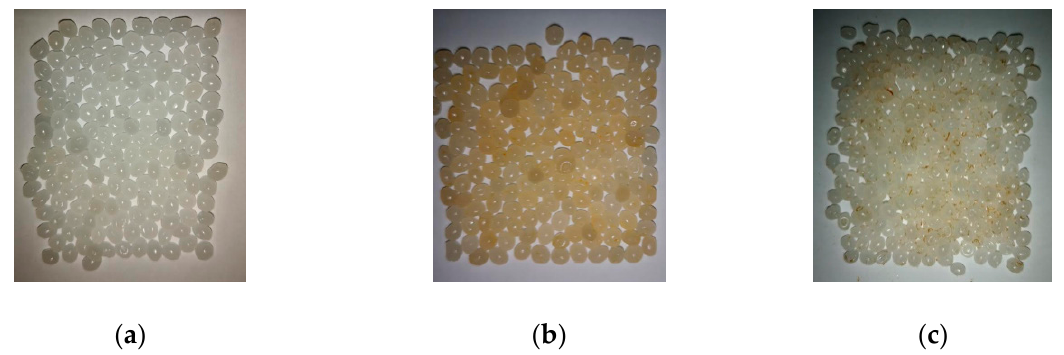
Figure 2. Images of ( a ) pure polylactide (PLA) granules; ( b ) PLA granules modified with myrrh ethanolic extract; ( c ) PLA granules modified with myrrh aqueous extract.